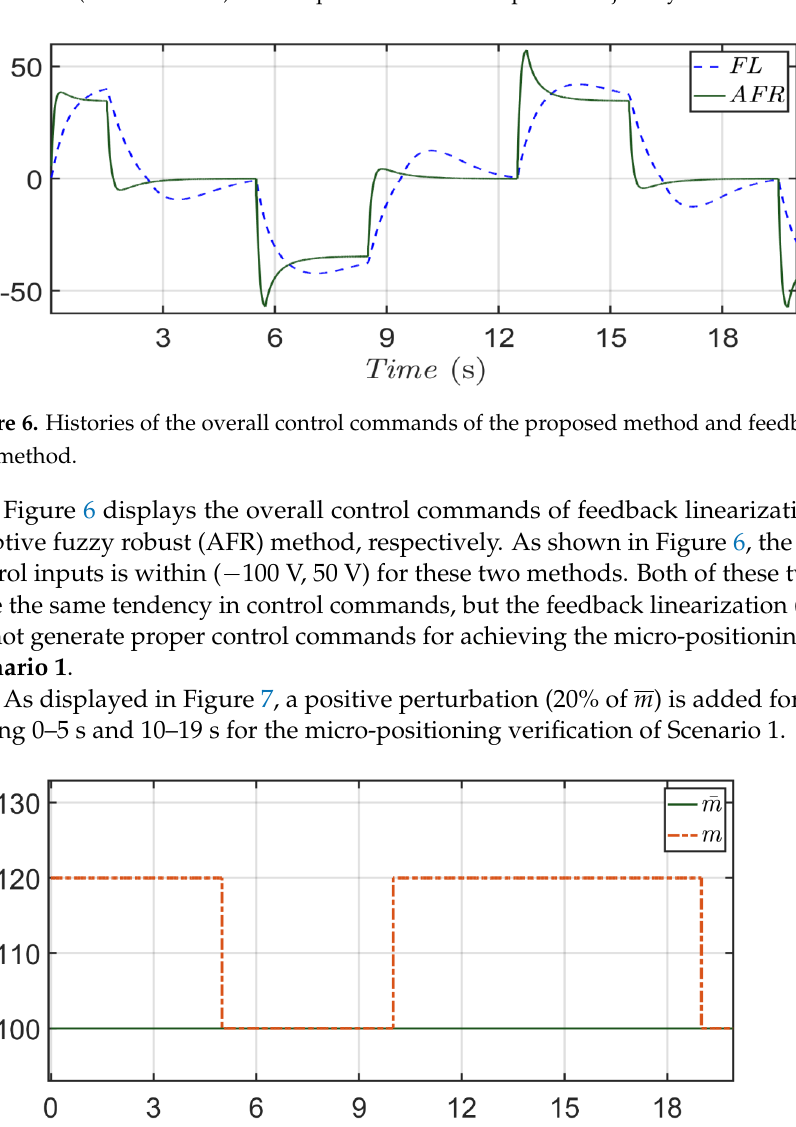
Figure 7. A time-varying positive perturbation (20% of m ) is added for m during 0 – 5 s and 10 – 19 s (red dotted line) in Scenario 1.